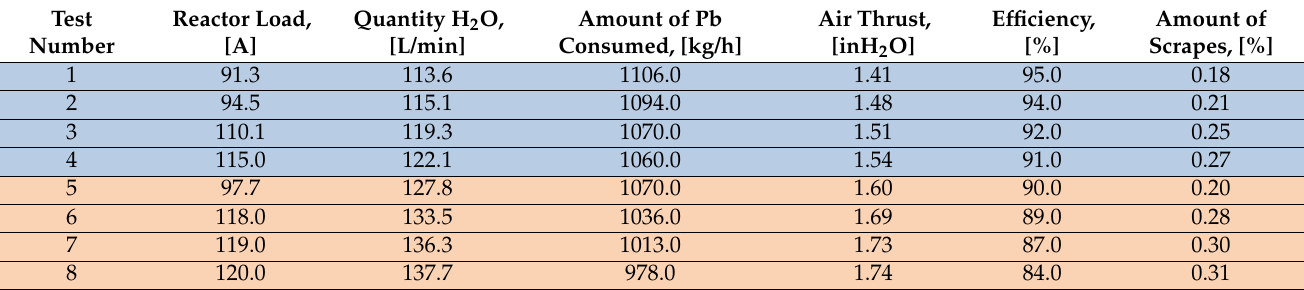
Table 3. Process parameters for lead oxide production (blue color—high humidity; brown color— low